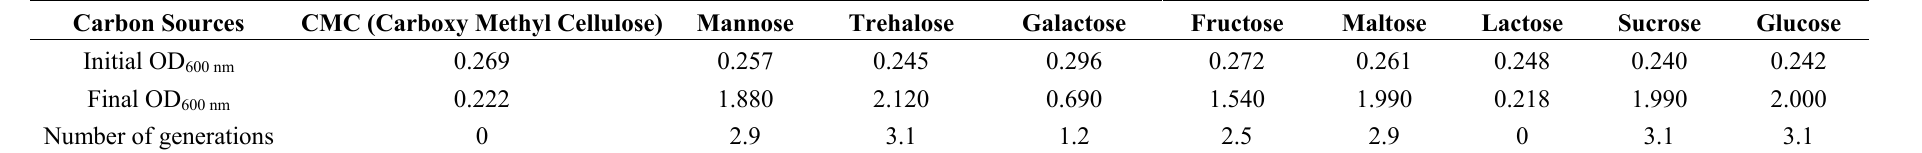
Table 7. Effect of nine carbon sources on the results of growth of Deinococcus geothermalis DSM-11302 in DMG. Carbon Sources